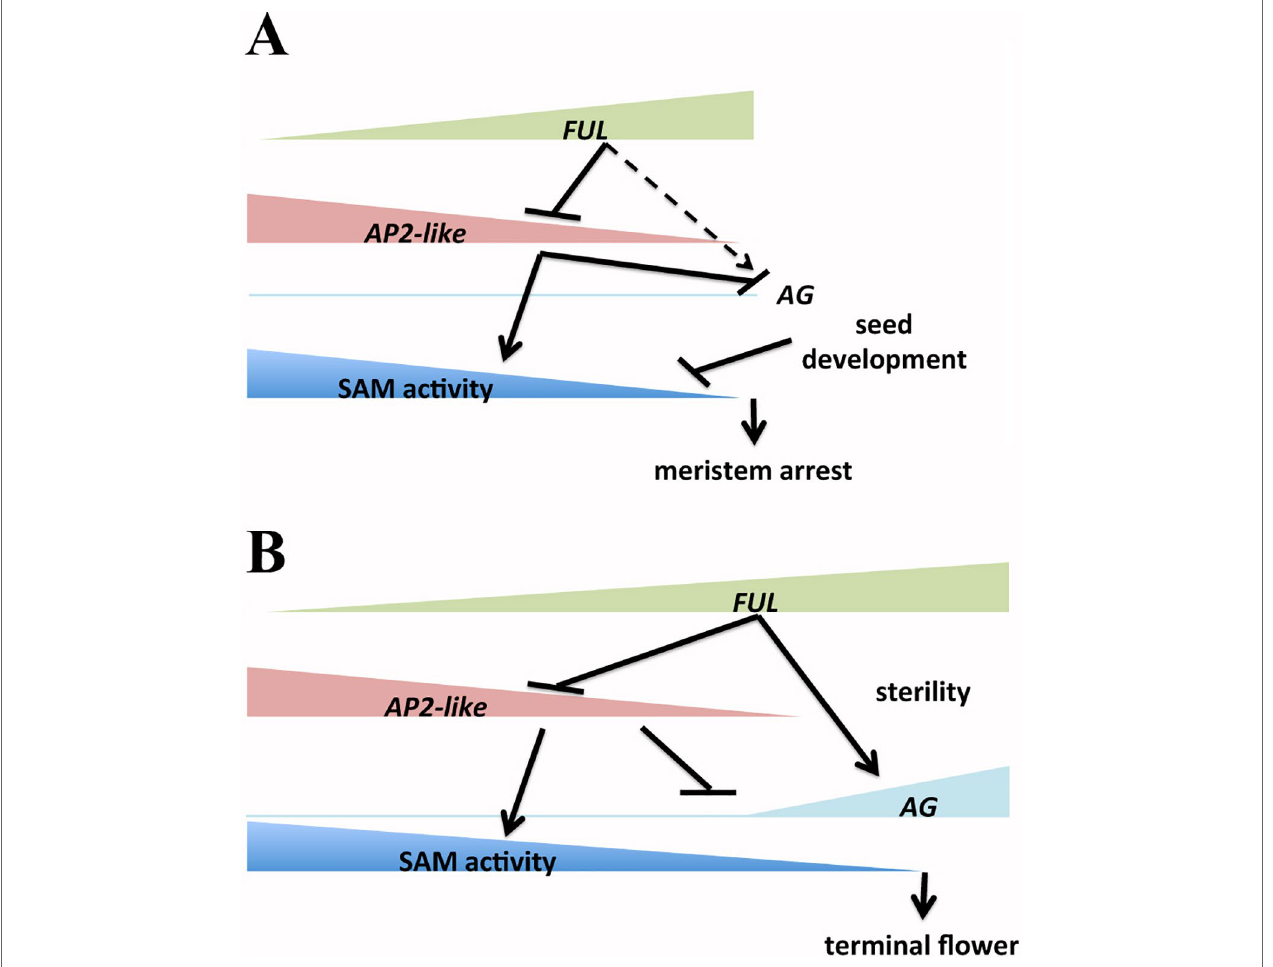
FIgURe 7 | Proposed model for the control of the end of the flowering phase in Arabidopsis . (a) In normal growth conditions the activity of the inflorescence shoot apical meristem (SAM) is controlled by the FUL-AP2 pathway and the correlative control exerted by the developing seeds. The combined action of both mechanisms induces the meristem arrest and the end of the flowering phase. During inflorescence progression, AP2 and AP2-like proteins control positively SAM meristem activity, and at the same time, repress AG expression as well as avoid AG activation by FUL in the SAM. (B) When the arrest-inductive seed effect is absent (as in sterile mutants or in pruned plants) the inflorescence meristem activity is extended in time. In these conditions, the increasing activity of FUL in the inflorescence meristem should reduce the AP2 and AP2-like levels. The decreasing levels of AP2 proteins would facilitate the direct activation of AG by FUL in the SAM, allowing the AG accumulation and the formation of the terminal